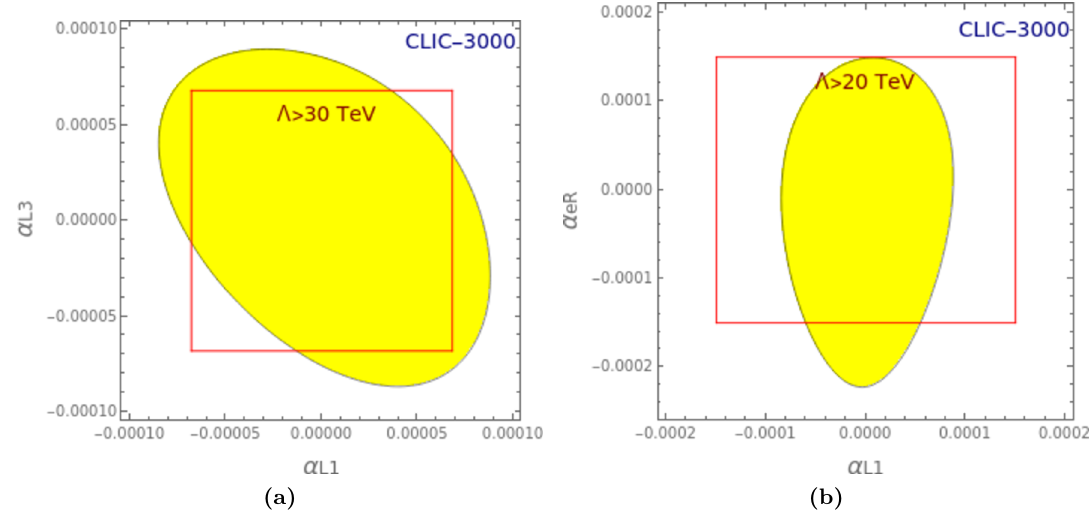
Figure 7. Projected sensitivities for the leptonic high-energy primaries, α e − c l, (1) v 2 / Λ 2 α L 3 = − c l, (3) v 2 / Λ 2 , at CLIC 3000 in 2-dimensional planes where the third parameter L L has been marginalised over. See the text for more